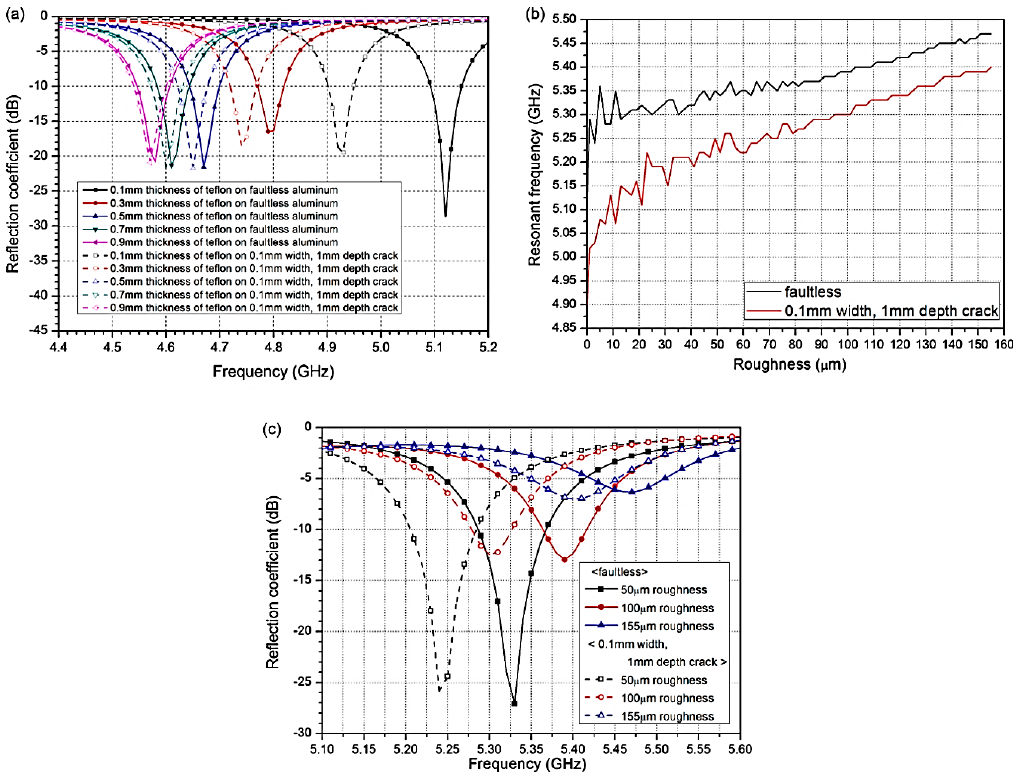
Figure 33. ( a ) Simulated reflection coefficients at different thicknesses of Teflon; ( b ) simulated resonant frequencies at different roughness levels on the top Teflon surface; and ( c ) the simulated reflection coefficients at 50 µ m, 100 µ m and 155 µ m roughness levels on the top Teflon surface for faultless and cracked (0.1 mm in width and 1 mm in depth) aluminum (from [41]; copyright © 2014; adopted with permission).